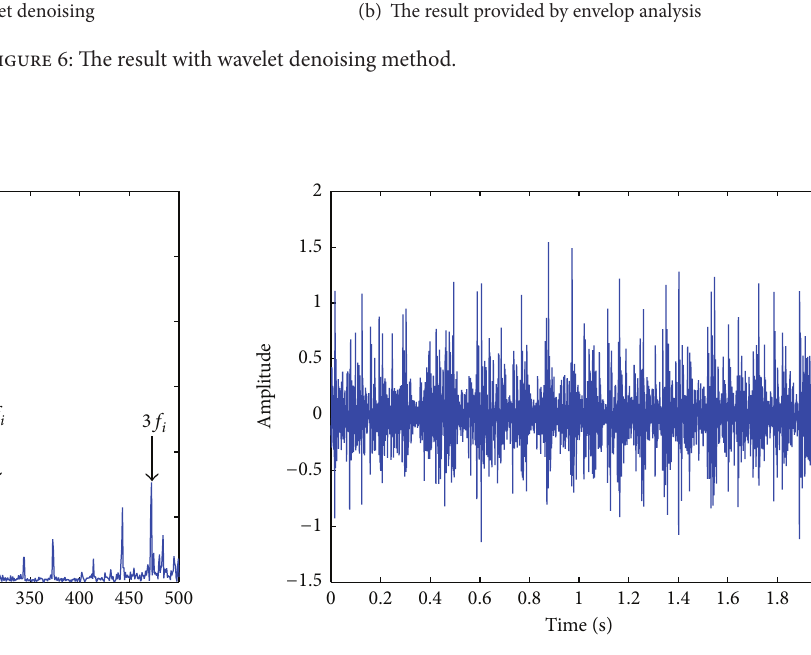
Figure 9: The vibration signal at measuring point